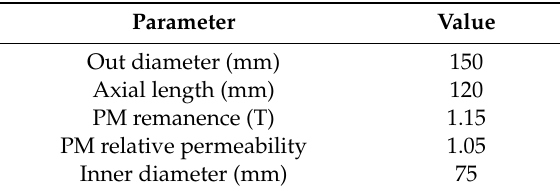
Table 2. Relevant parameters of motor.